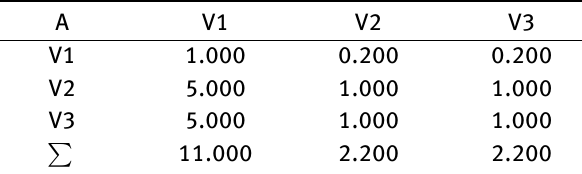
Table 5: Comparison of variants in accordance with processing time.